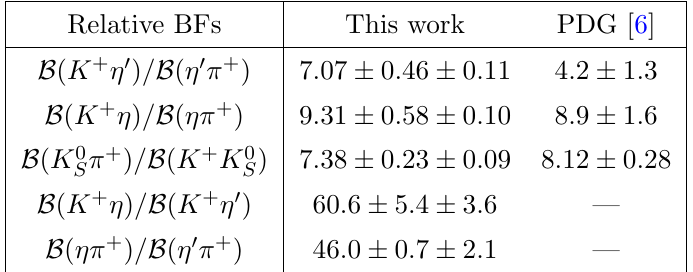
Table 5 . Results of the obtained relative BFs (in unit of %). The (cid:12)rst uncertainty is statistical, and the second is